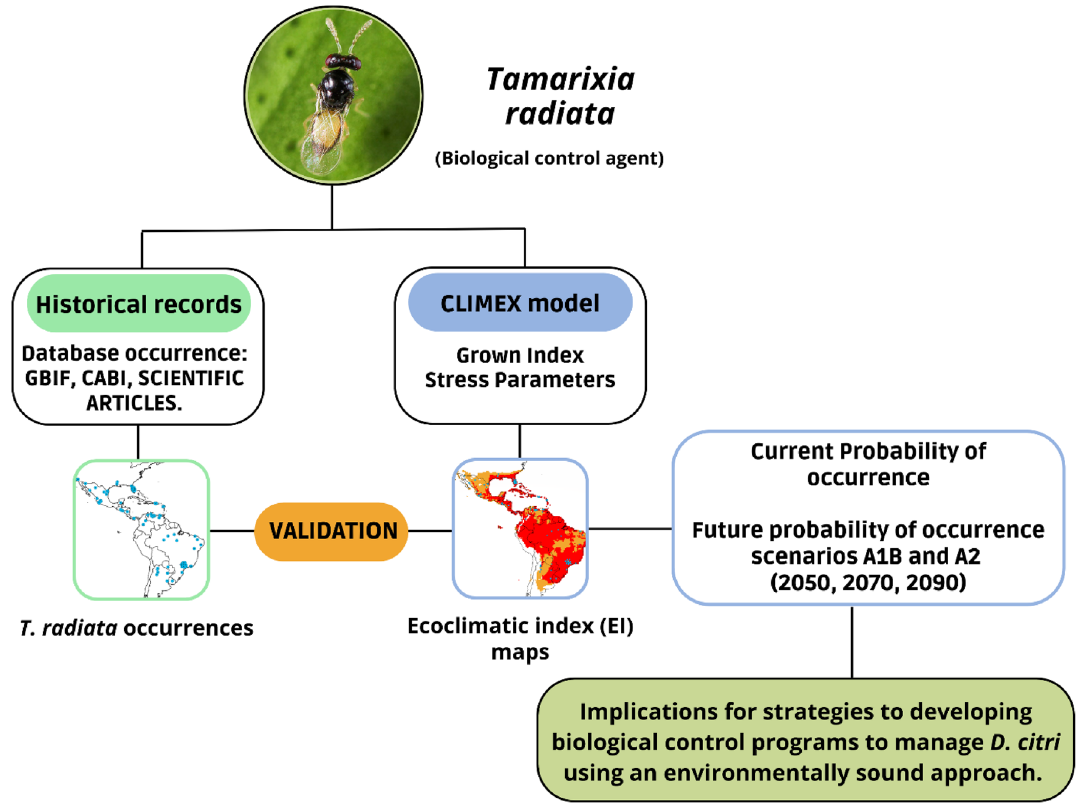
Figure 1. Technical flow chart of the study.